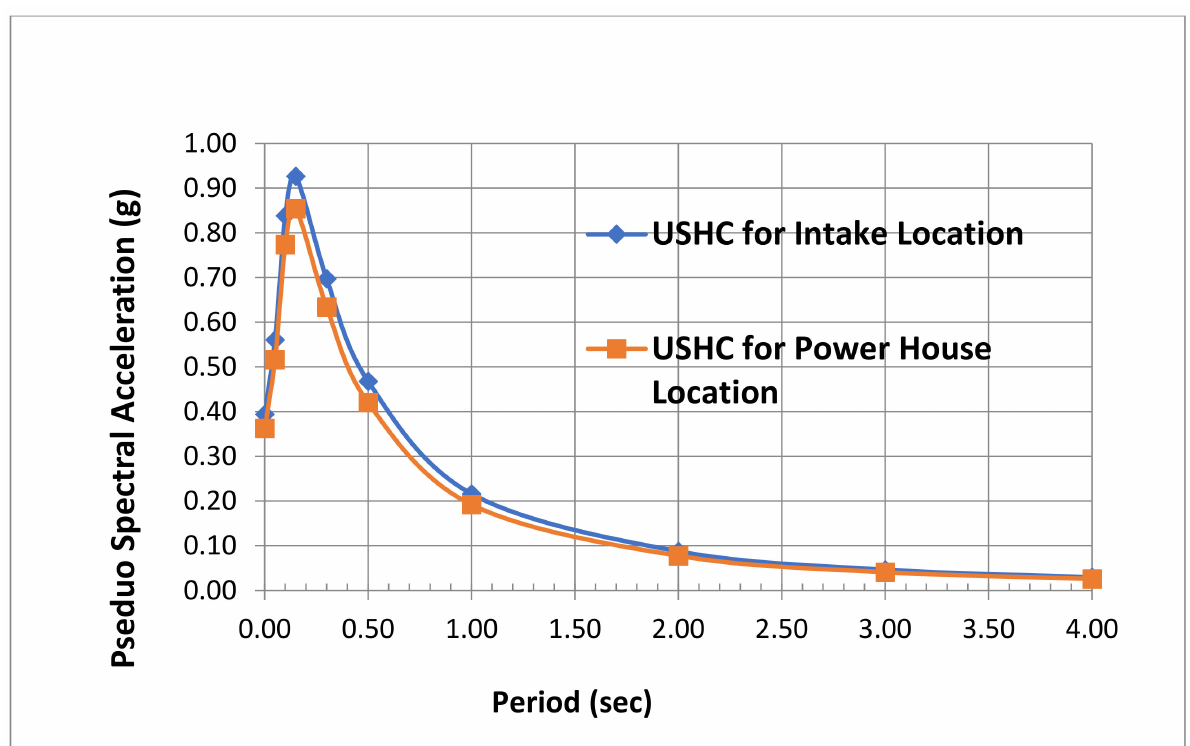
Figure 16. Uniform spectral hazard curve (USHC) for the intake and the powerhouse locations of the Shigo Kas